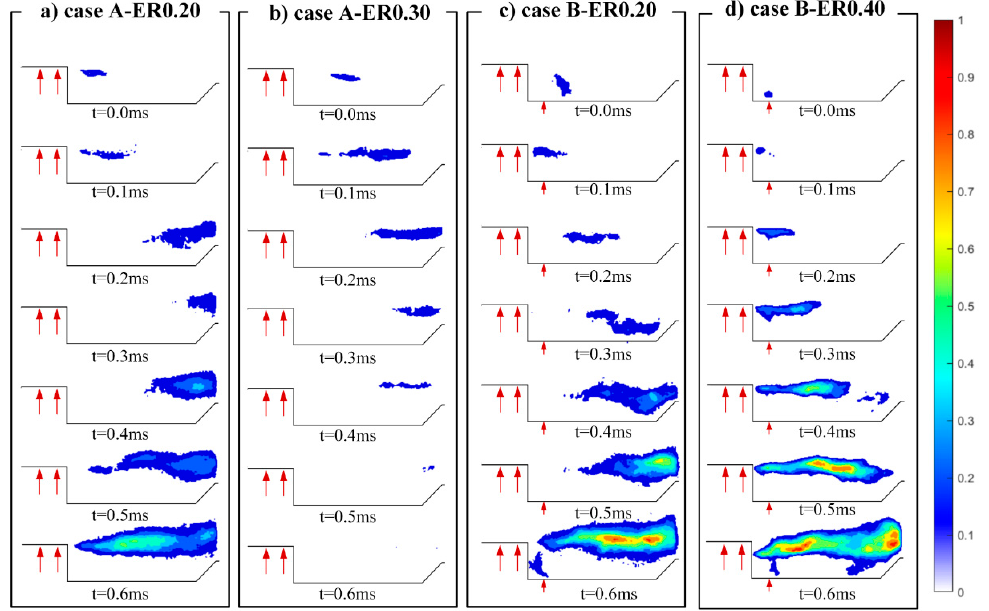
Figure 4. Sequential images of CH* spontaneous emission images in the cases of injection Scheme A at ER = 0.2 and 0.3 and injection Scheme B at ER = 0.2 and 0.4 (failure ignition occurs in case A-ER0.30; different initial flame propagations are observed in the case A-ER0.20, B-ER0.20, and B-ER0.40).